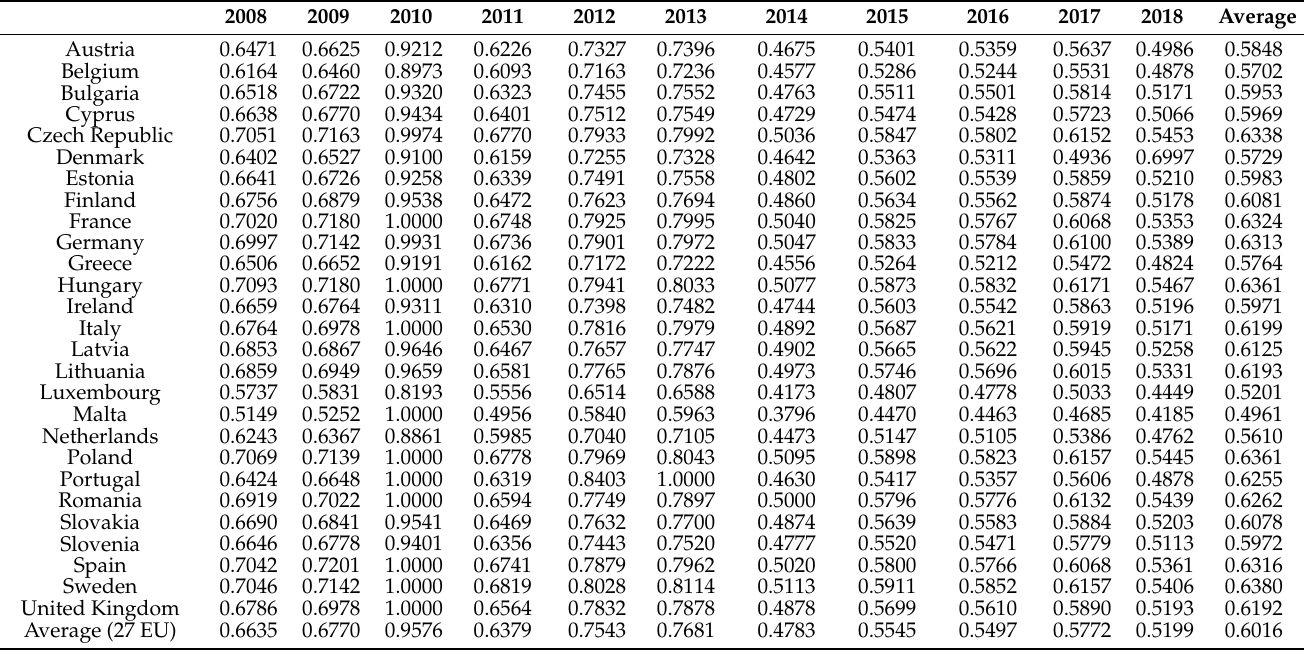
Table 2. Scores of technical eco-efficiency estimation in EU-27 under data envelopment analysis (DEA)-constant returns to scale (CRS): 2008–2018 period.